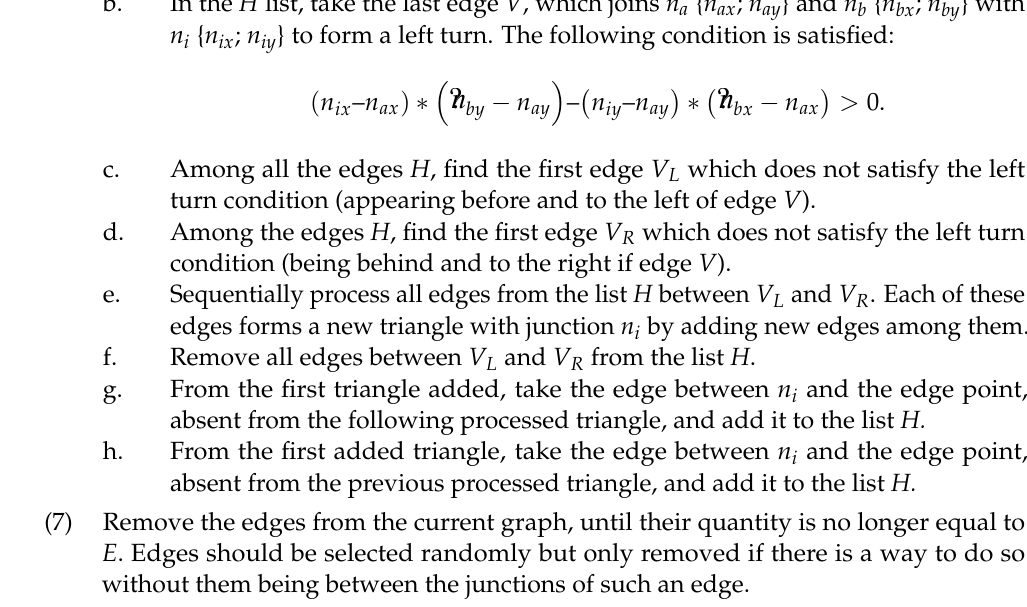
Figure 4. Example of an accidental planar network consisting of 500 junctions with an average number of links equal to 2.9. 4.2. Network Percolation Threshold Calculation Algorithm The network percolation threshold algorithm used consists of the following steps [24]: (1) Randomly select two network junctions A and B, considering limits, with at least one intermediate junction between them. (2) Set the blocking probability value of the single junction (in the junction task) or link (for the link task) and randomly block the junction (or link) fraction which is equal to this probability. (3) Check for the presence of at least one “free” way in the network (a route which is included in the junction or link list) from junction A to junction B. If no “free” way is present (i.e., number of “free” ways is equal to 0), record 0. Otherwise, record 1. (4) Increase the blocking probability value of a single junction (for the junction task) or link (for the link task) on any value. Then, randomly block the fraction of network junctions (or links), equal to the specified probability value. Next, indicate the spe- cific network junctions being excluded. (5) Repeat step 3, until all network junctions have been processed. (6) Return to step 2 and execute steps 3–5 Q times (for example, several hundred times). Repeat all steps (if the whole network is blocked) on all experiments. Indicate